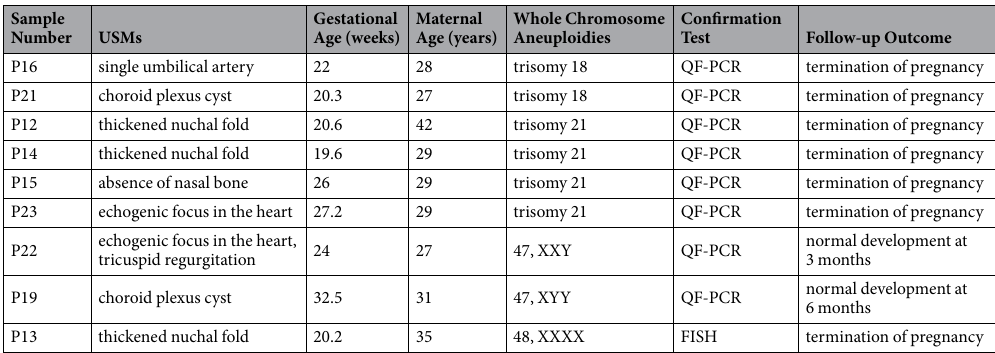
Table 2. Whole chromosome aneuploidies of the 782 fetuses with